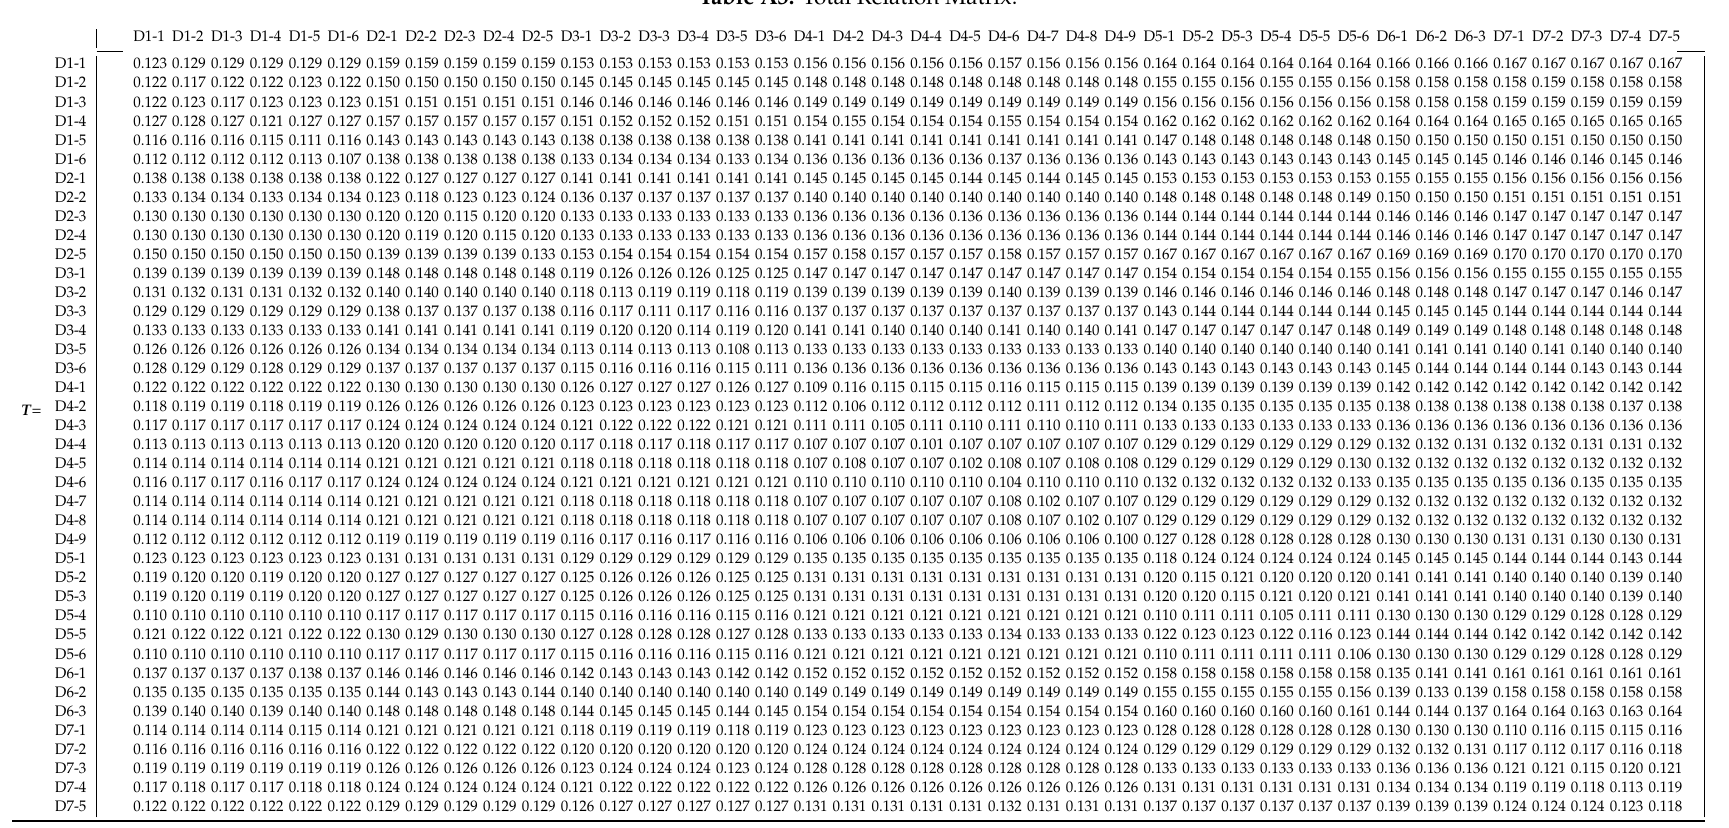
Table A3. Total Relation